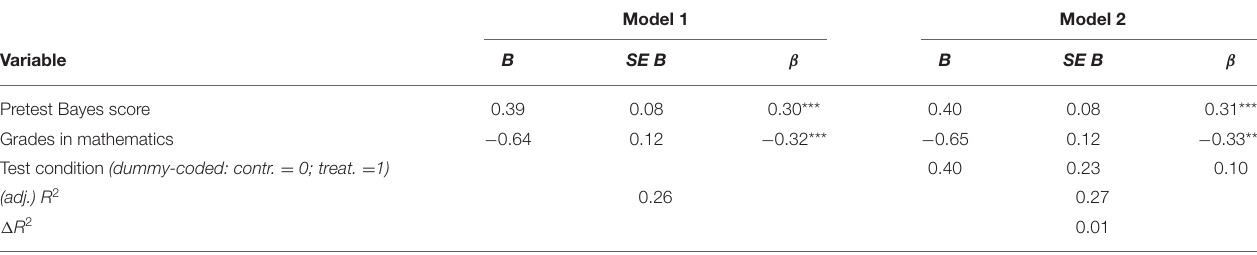
TABLE 3 | Prediction of the follow-up test results of the Bayesian